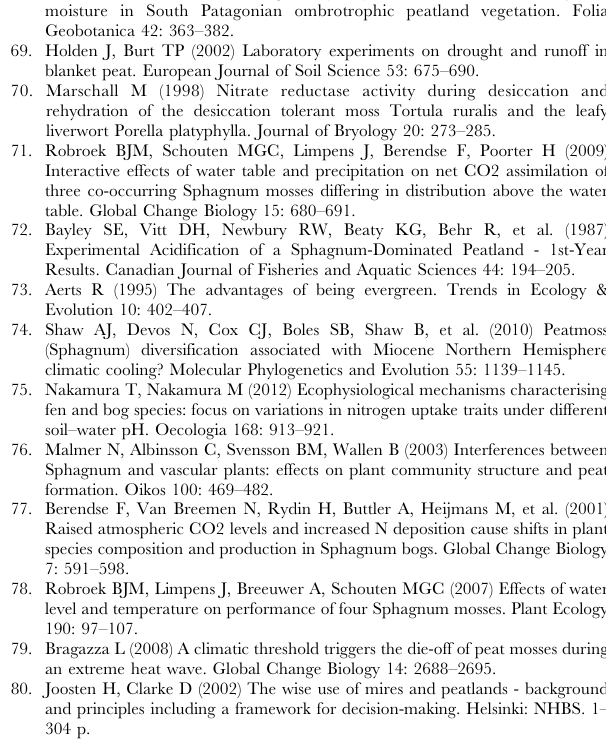
table. Global Change Biology 15: 680–691. 72. Bayley SE, Vitt DH, Newbury RW, Beaty KG, Behr R, et al.